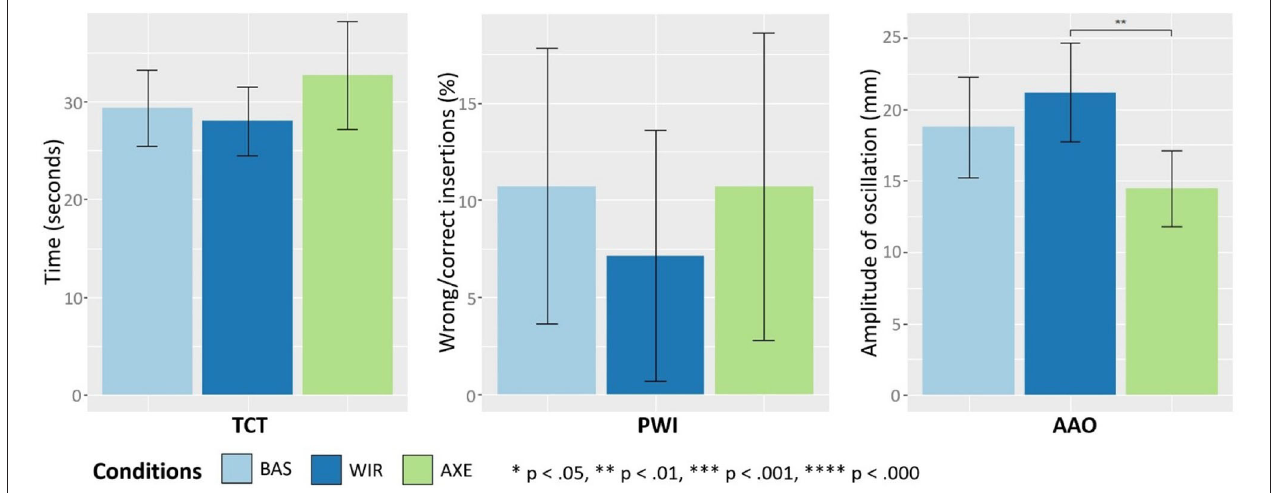
FIGURE 5 | Effect of the [VISUAL] conditions on objective measures. Bar plot indicate mean values. Error bars indicate confidence intervals.